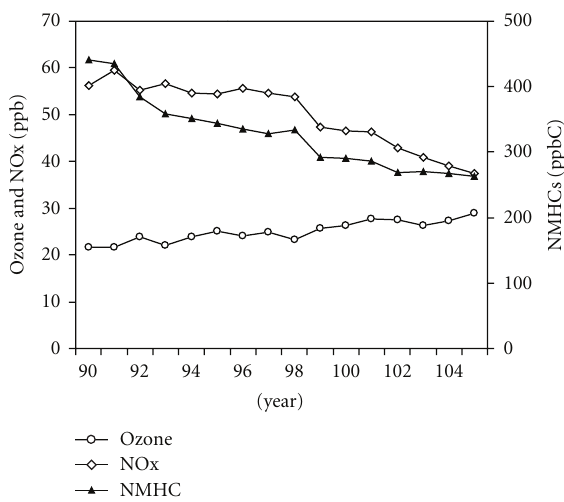
Figure 2: Annual average pollutant concentrations during 1990– 2005 in the Tokyo area (see Figure 8; source: National Institute for Environmental Studies,